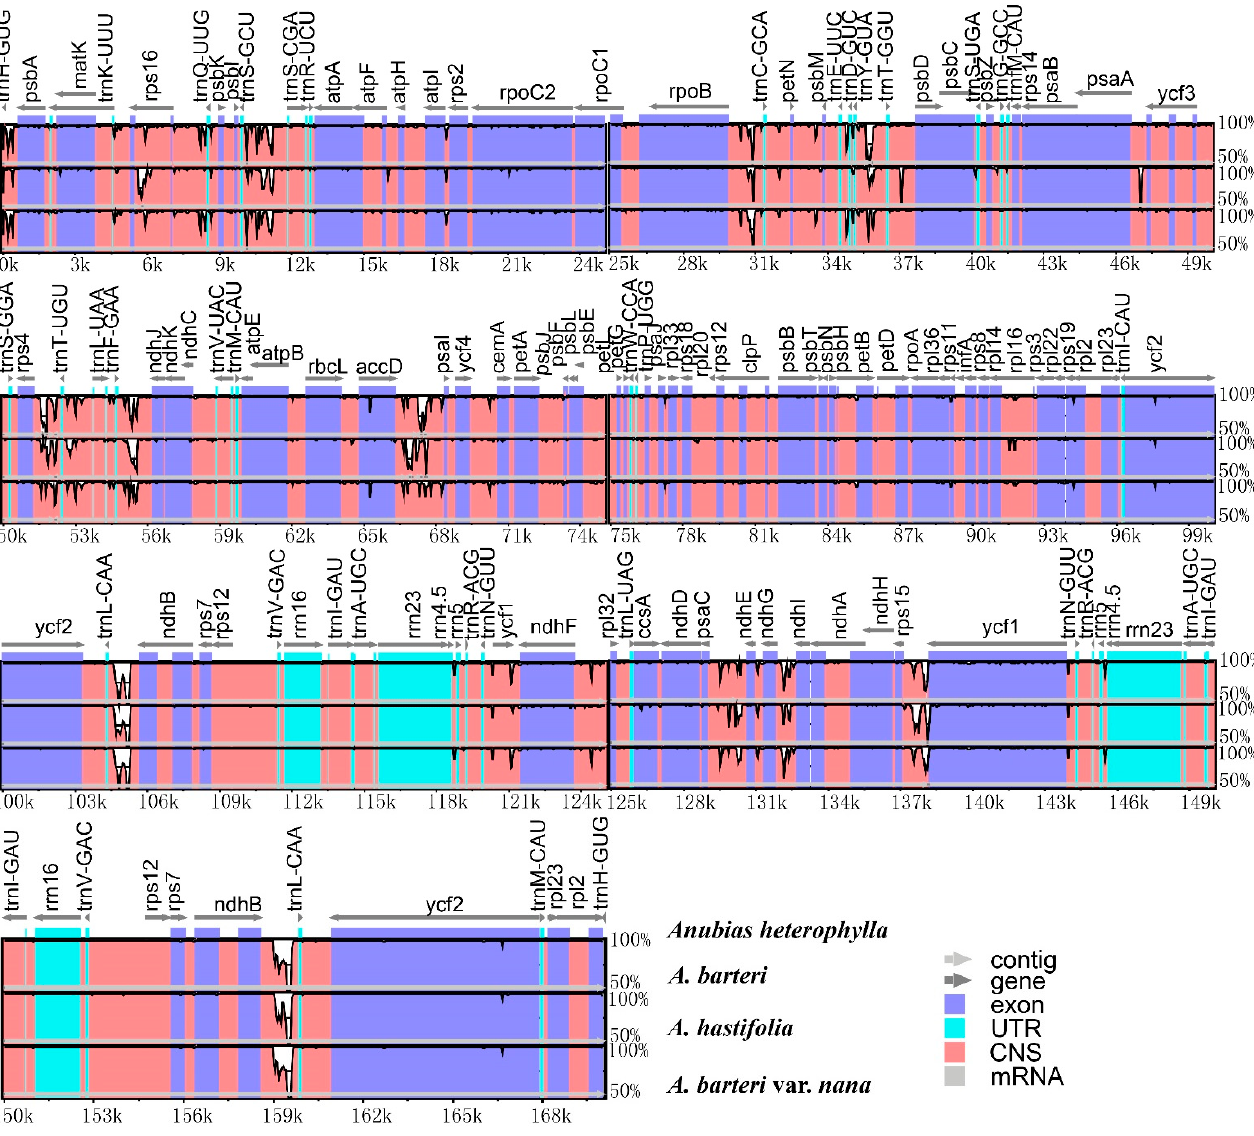
Figure 4. Nucleotide diversity and hotspot regions of four Anubias plastomes.